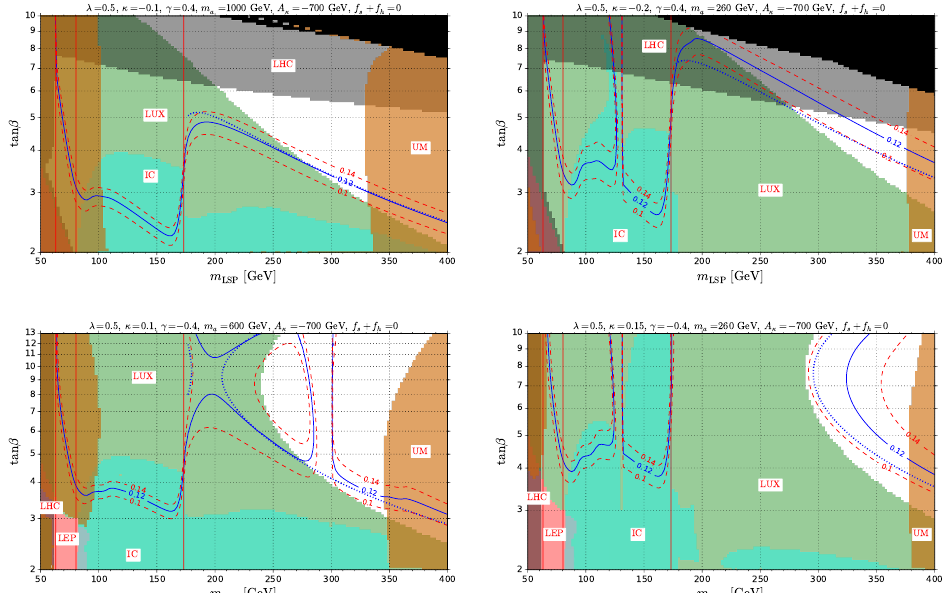
Figure 5 . The same as in (cid:12)gure 1 but for m s < m h . We took m (cid:31) > 0, (cid:22) > 0, m H = 4 TeV, m s = 95 GeV and j (cid:13) j = 0 : 4, which corresponds to (cid:1) mix (cid:24) 4 GeV. In brown areas NMSSMTools reports unphysical global minimum (UM) while in grey ones the LHC constraints on the Higgs production and decay are violated (LHC). Black regions in the upper right corners denote the points where the condition (4.5) does not